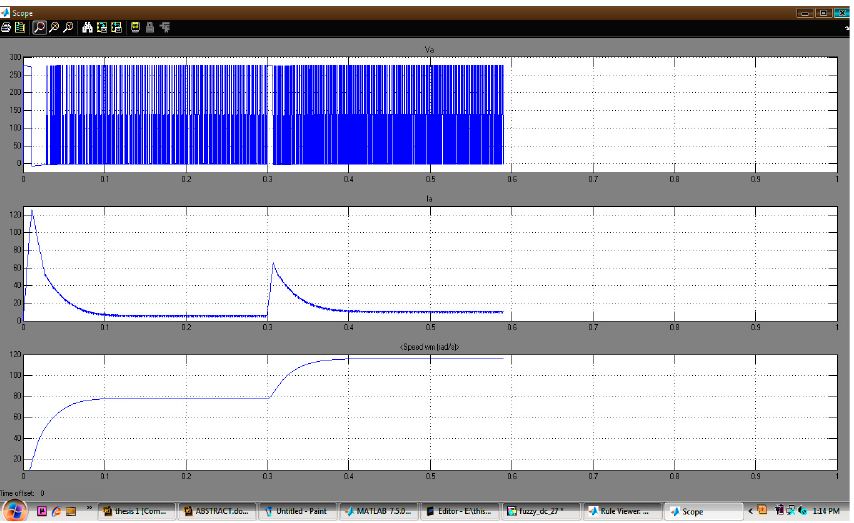
Figure 16. Simulation results of novel PSO fuzzy controller for the speed of 80 rad/s and final 120 rad/s.